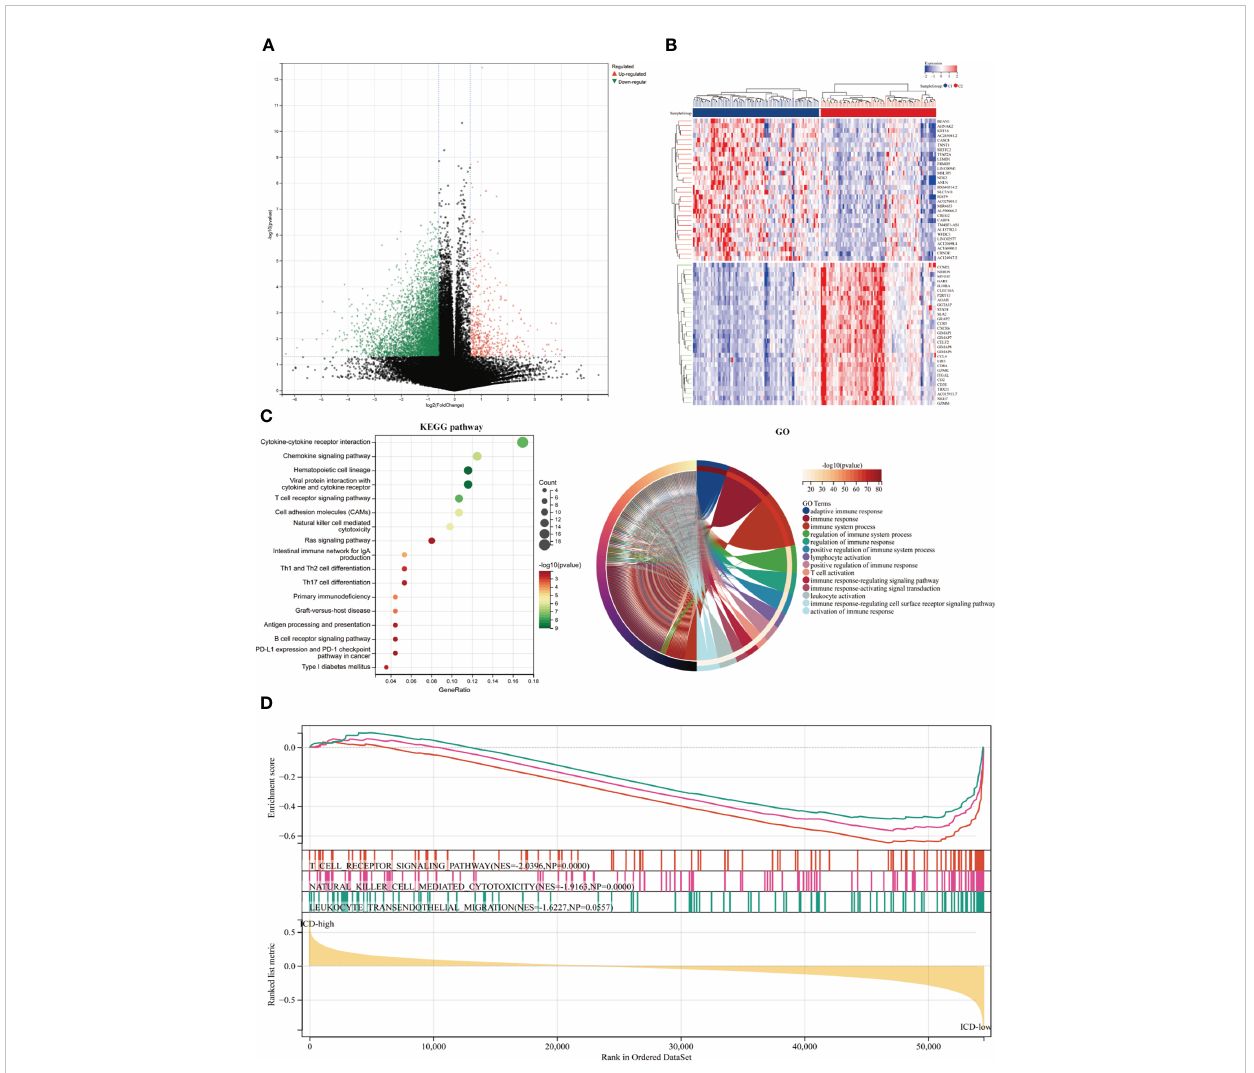
FIGURE 2 Identifying differentially expressed genes (DEGs) and underlying signaling pathways in various subtypes. (A) The volcano fi gure depicted the distribution of DEGs measured between ICD-high and ICD-low subgroups in the TCGA cohort, with a threshold of |log2 Fold change| > 1 and P 0.05. (B) The heatmap depicted the expression of DEG in various subtypes. (C) The KEGG and GO signaling pathway enrichment analyses were shown by dot and circle plots. The dot size re fl ected gene count, and the dot color denoted - log10 (p. adjust-value); (D) GSEA analysis identi fi ed the fundamental signal pathway that differentiated ICD-high and ICD-low